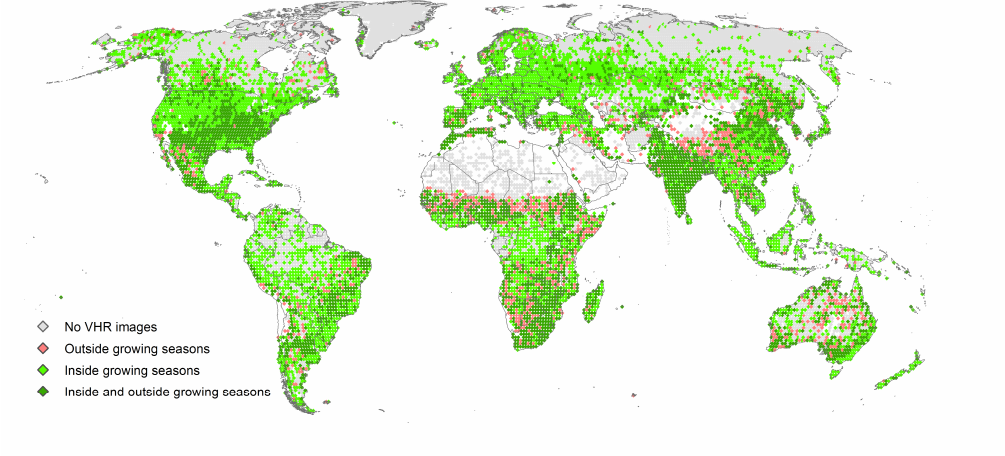
Figure 7. The distribution of VHR imagery (<5 m) in Google Earth based on the availability in and outside of a growing season. Areas in white, e.g., in the Sahara desert, were excluded since there is no data available due to absence of cropland (Software: Esri ® ArcMap™